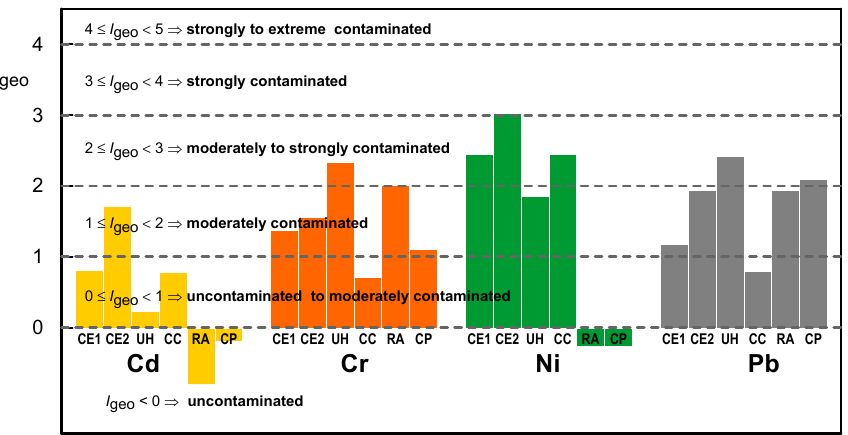
Figure 4. I geo values calculated for each metal (Pb, Ni, Cr and Cd) in each sampled site.